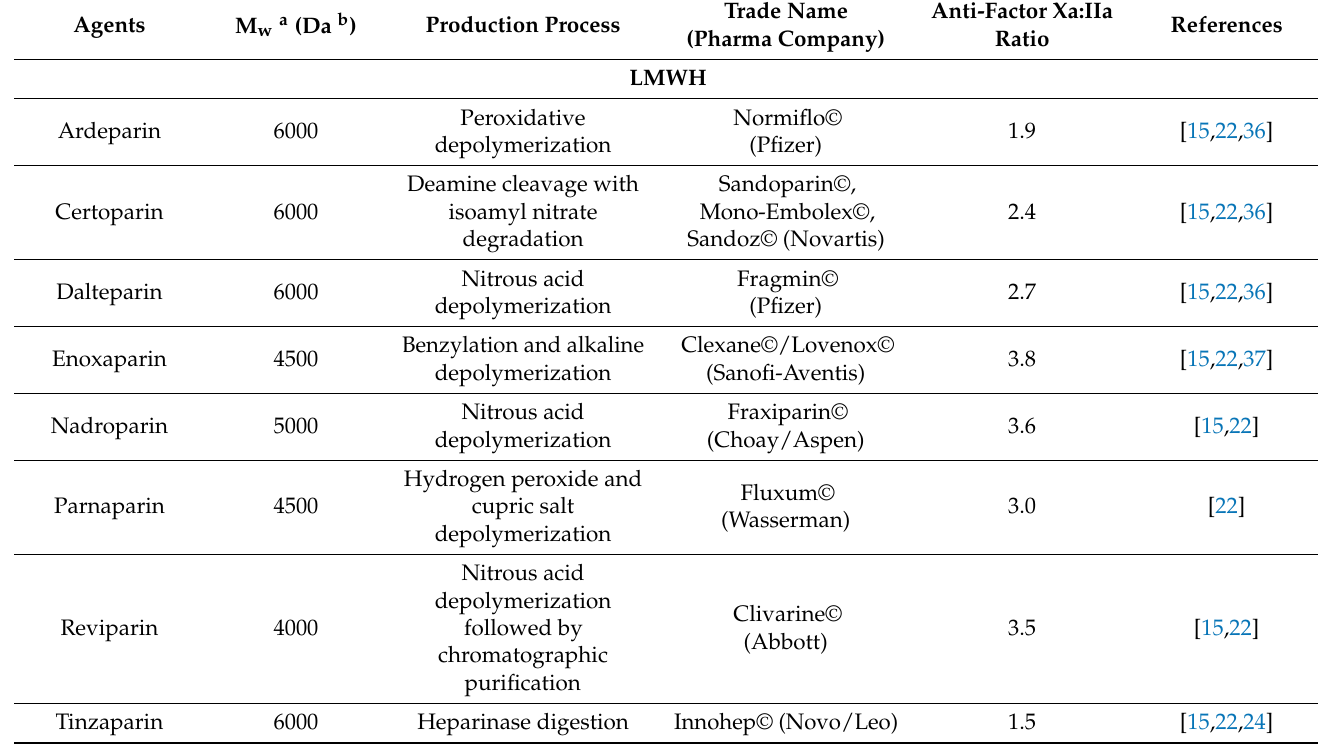
Table 1. Comparative features of LMWHs, ULMWHs, and their synthetic analogues. Agents M w a (Da b